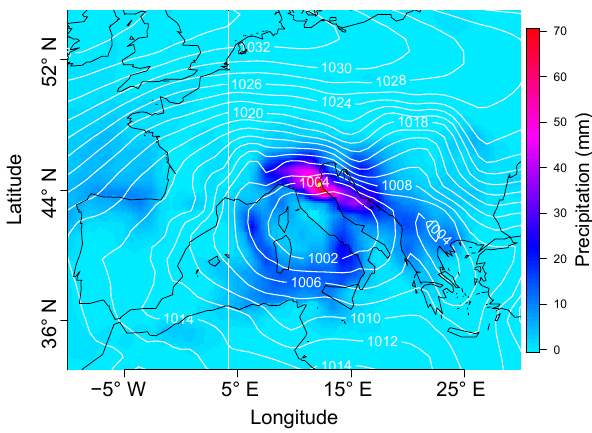
Figure 1. Sea level pressure and total precipitation on 6 Febru- ary 2015, when the coastal area of Ravenna (indicated by the yellow dot) was hit by a compound